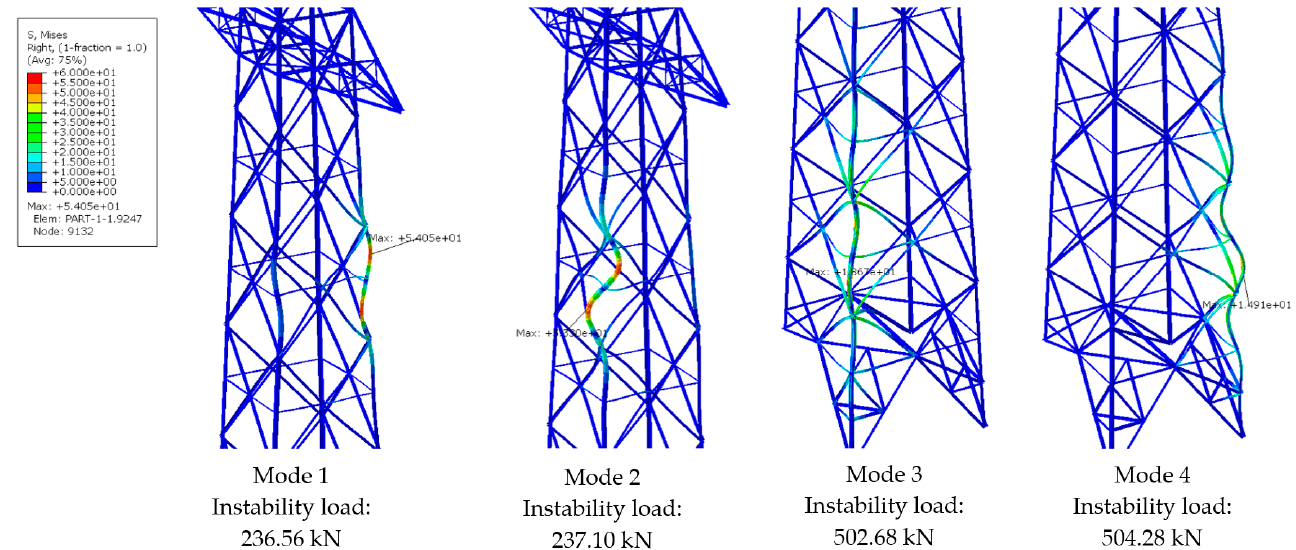
Figure 22. Buckling modes shapes and instability loads from the LBA; results with transverse wind forcing (0°), scale factor = 500. The two pictures on the left show the failure at the 7th and 8th level of the tower, whereas the two on the right show the failure at the 2nd level.